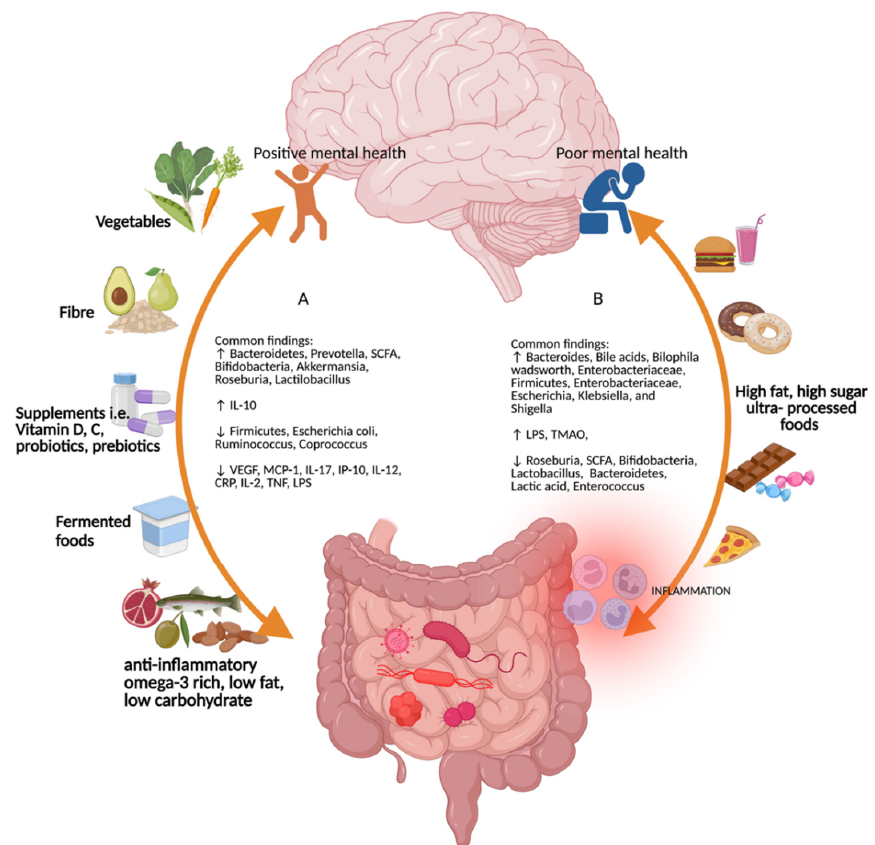
Figure 2. Common findings for the different types of diet on the gut–brain–microbiome axis. ( A ) Diets rich in vegetables, fiber, micronutrients such as vitamins D and C, probiotics and prebiotics,